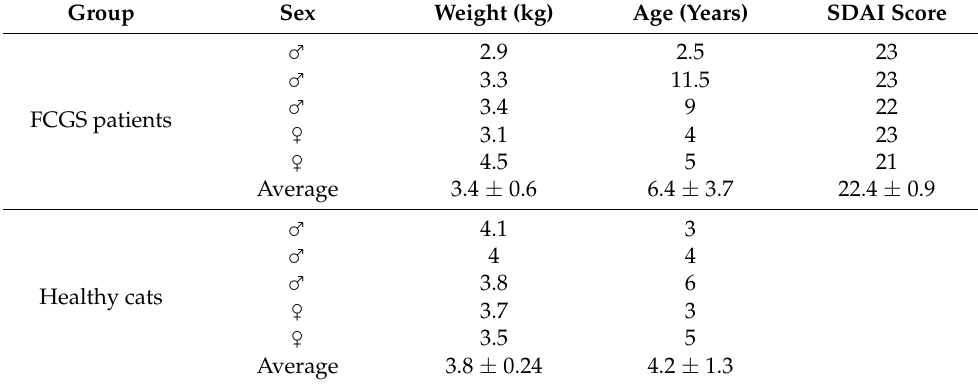
Table 1. Sex, age, weight, and SDAI scores of the cats selected for this study. The animals were the same as those previously used to analyze the protein profiles of exosomes produced by their fAd-MSCs [20]. Group Sex Weight (kg) Age (Years) SDAI Score